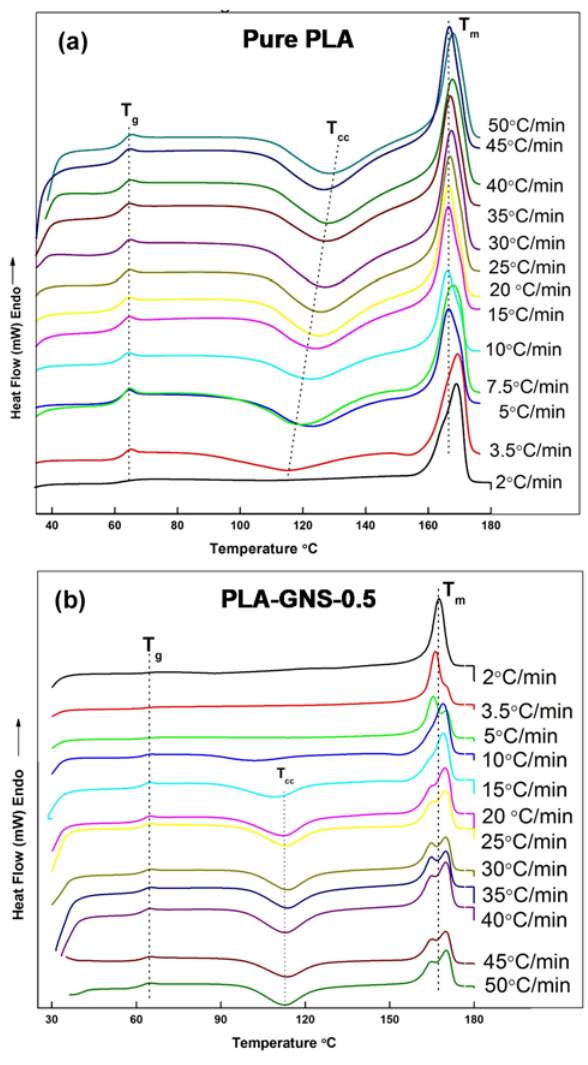
Figure 2. ( a ) DSC thermograms of pure PLA crystallized at various cooling rates, while ( b ) represents DSC thermograms of PLA-GNS nanohybrid at various cooling rates.